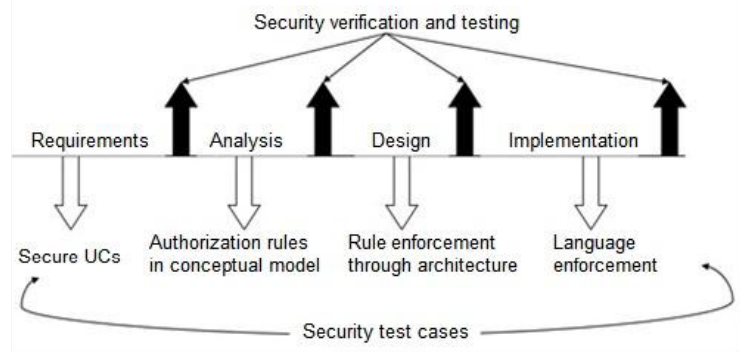
Figure 19. Overview of security verification over the life cycle.